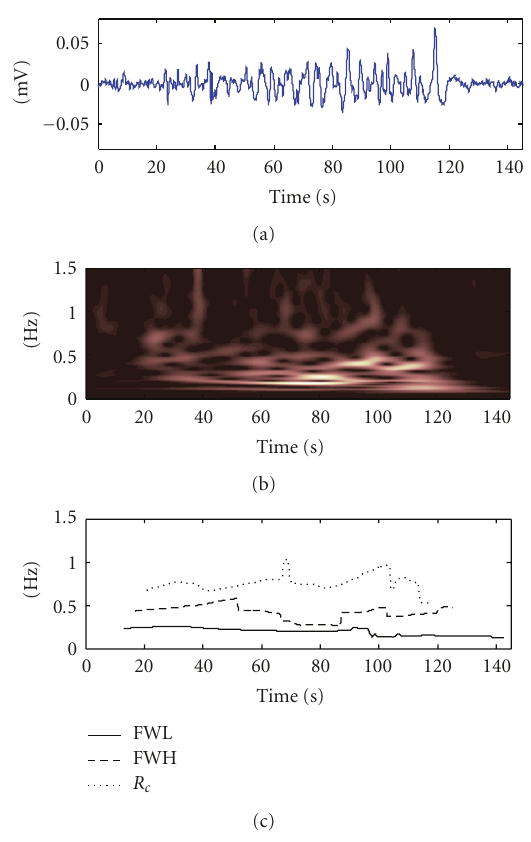
Figure 3: Example of a pregnancy contraction (a), the correspond- ing scalogram (b) and the extracted ridges corresponding to FWL, FWL and a complementary ridge R c